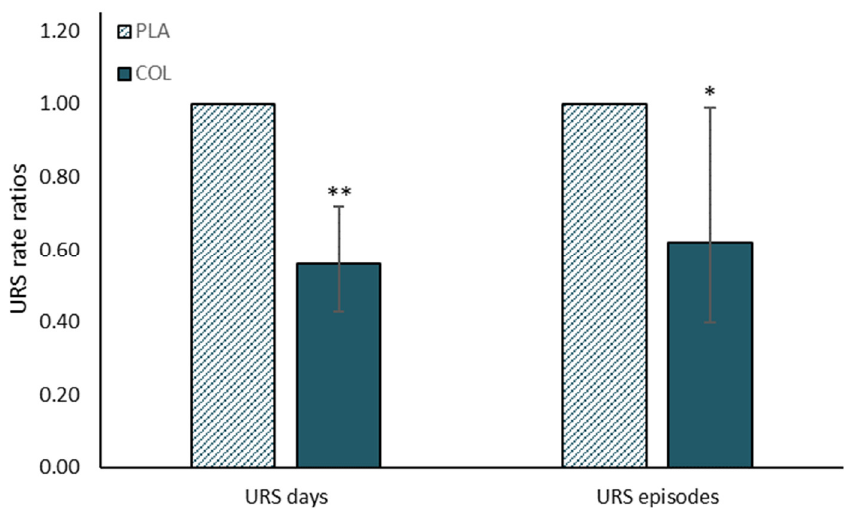
Figure 2. Summary of findings from Jones et al. [71] meta-analysis on effects of bovine colostrum supplementation on upper respiratory symptoms during exercise training. URS days, self-reported total days with symptoms; URS episodes, number of episodes during monitoring period. PLA bars show reference rate ratio of 1.0, and COL bars show rate ratio relative to PLA and 95% confidence intervals. * p < 0.05, ** p < 0.01 compared with PLA.